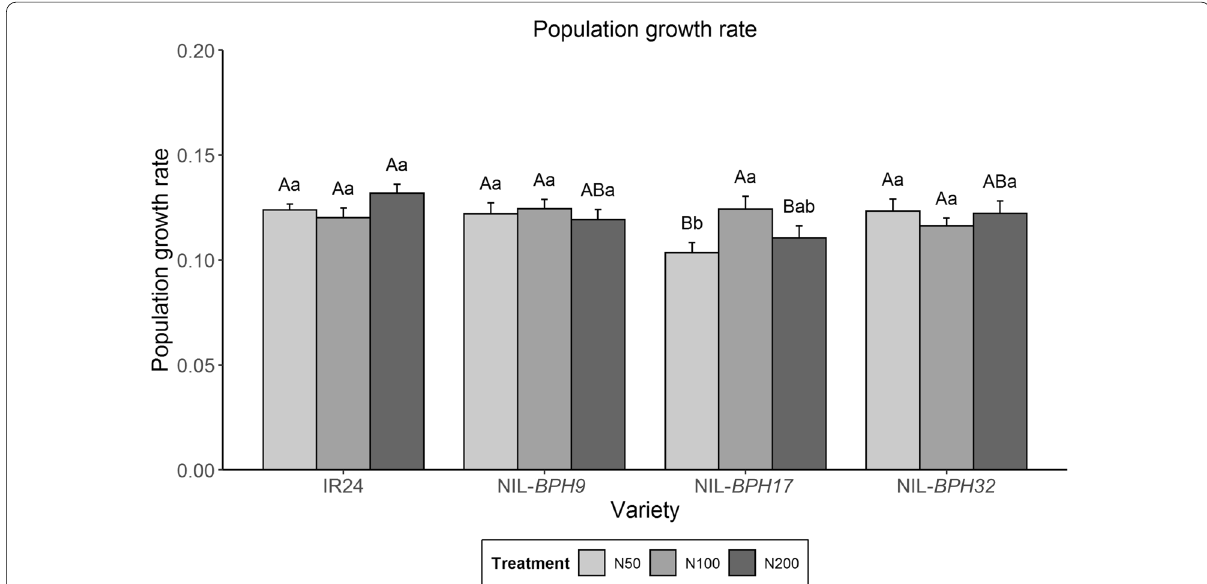
Fig. 3 Population growth rate of N. lugens nymphs feeding on IR24, NIL‑ BPH9 , NIL‑ BPH17 , and NIL‑ BPH32 under different nitrogen regimes. Means in each column followed by the same capital letter do not differ significantly among varieties ( p < 0.05). Means in each column followed by the same lowercase letter do not differ significantly among different nitrogen treatments. The error bars indicate the S.Es